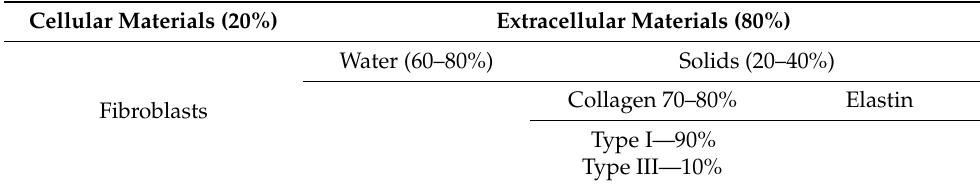
Table 1. Typical composition of ACL tissue [9].